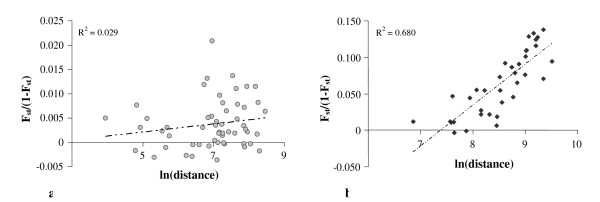
Pairwise differentiation versus the natural logarithm of the distances (in km) following Rousset's two-dimensional isolation by distance model. a) Plot based on the analyses of 25 X-chromosome SNPs in 11 Mediterranean populations: Fst/(1 - Fst) = 0.001*ln(dist.) - 0.004. b) Analysis carried out on 9 worldwide populations and 21 SNPs: Fst/(1 - Fst) = 0.062*ln(dist.) - 0.470.